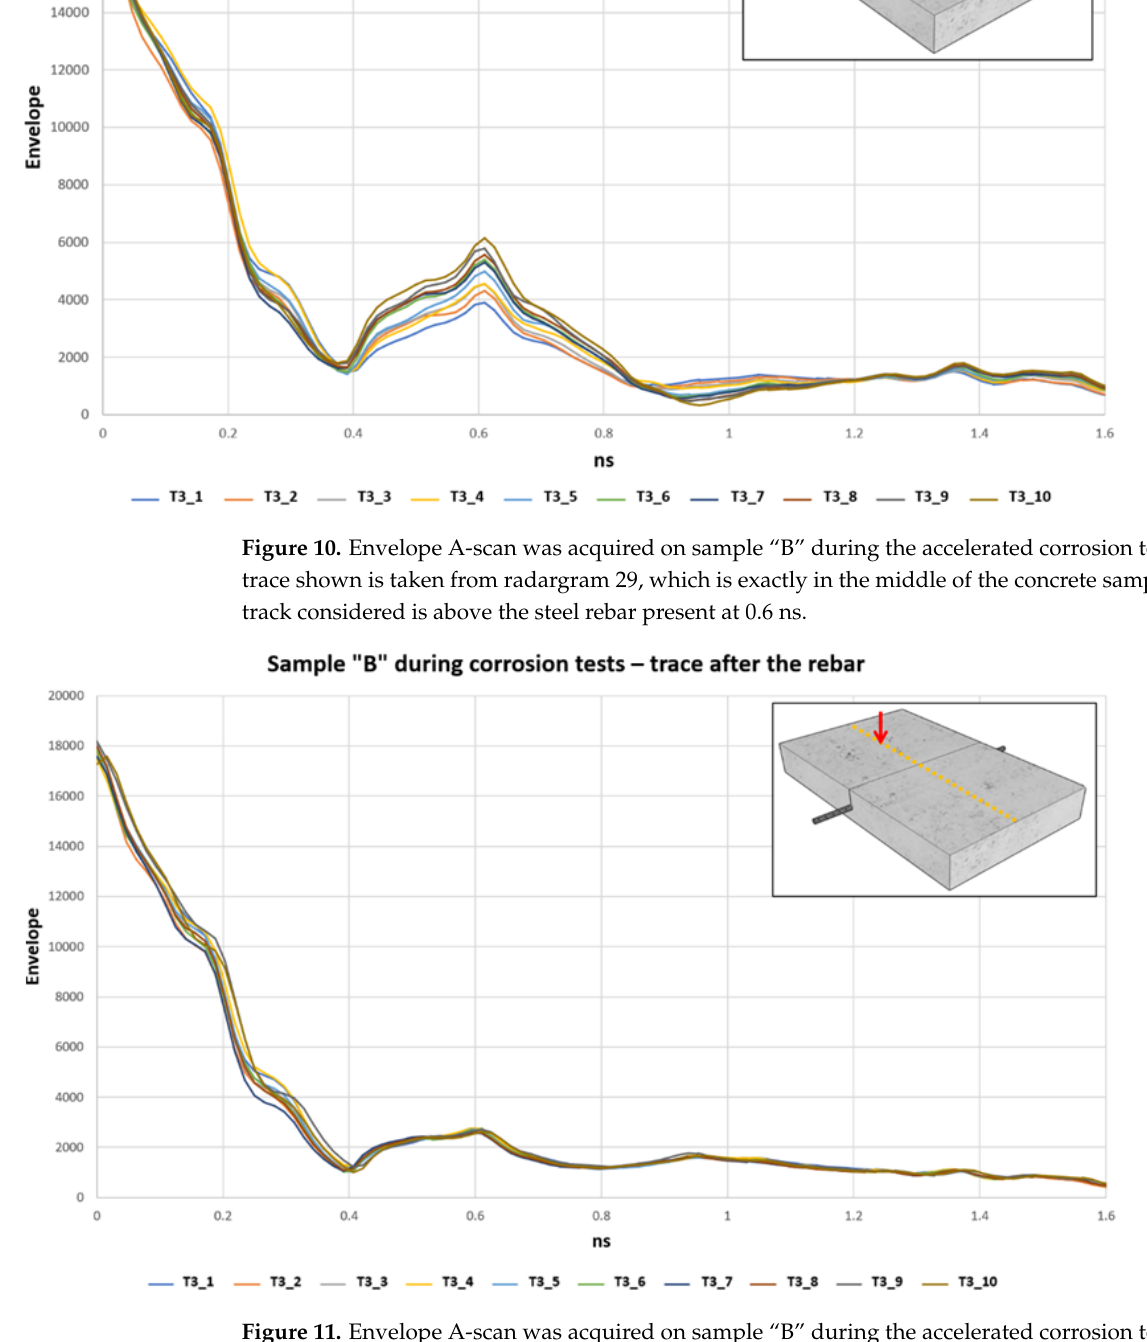
Figure 11. Envelope A-scan was acquired on sample “B” during the accelerated corrosion test. The trace shown is taken from radargram n°29, at 10 cm after steel rebar, inside the concrete sample. From the graph, we can see that there were no changes in the envelope A-scan trace during the corrosion test.